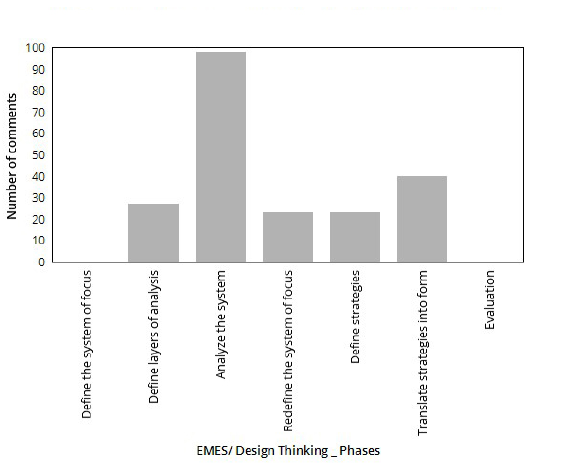
Figure 12. EIMS contribution to support the design thinking methodology